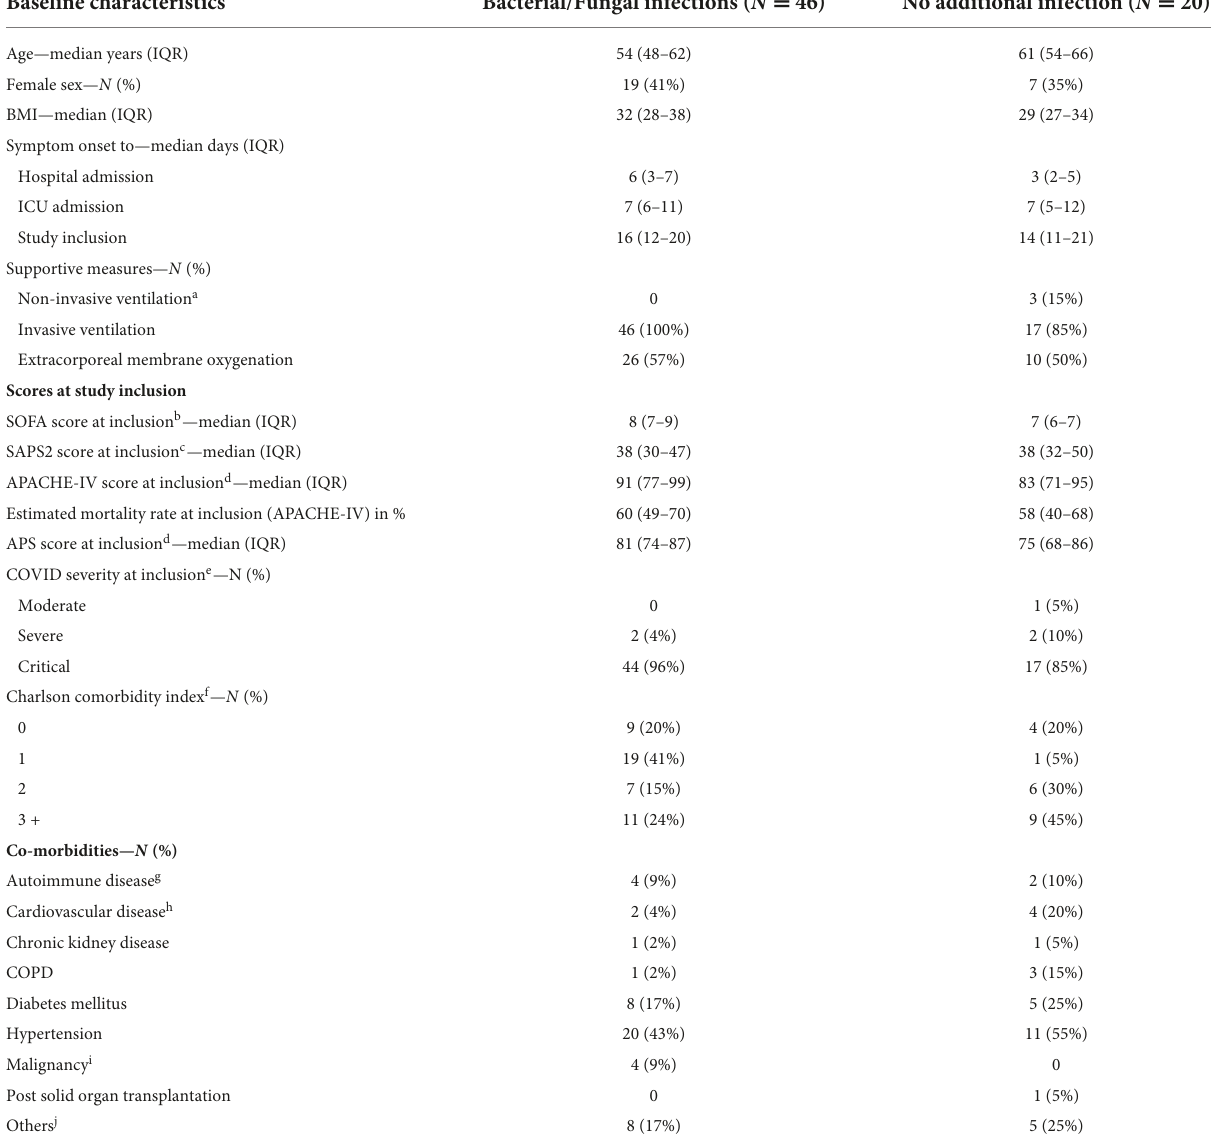
TABLE 1 Patients characteristics and outcomes ( N = 66). Baseline